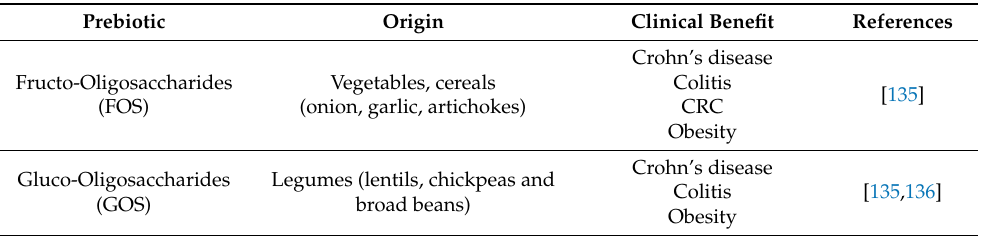
Table 3. Prebiotic-rich foods and their e ff ects on human